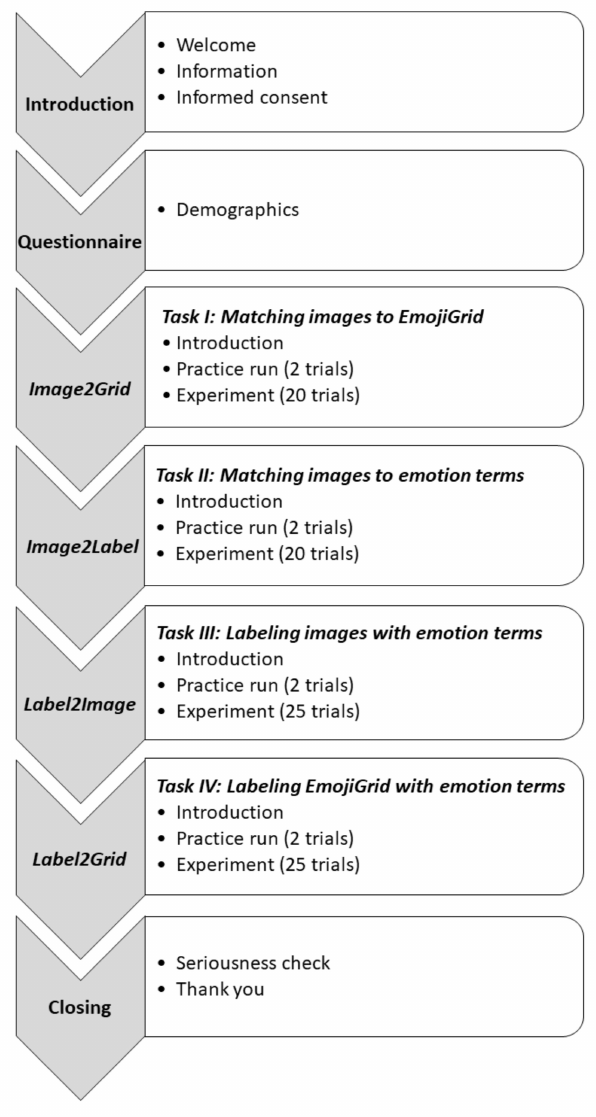
Figure 5. Schematic representation of the experimental